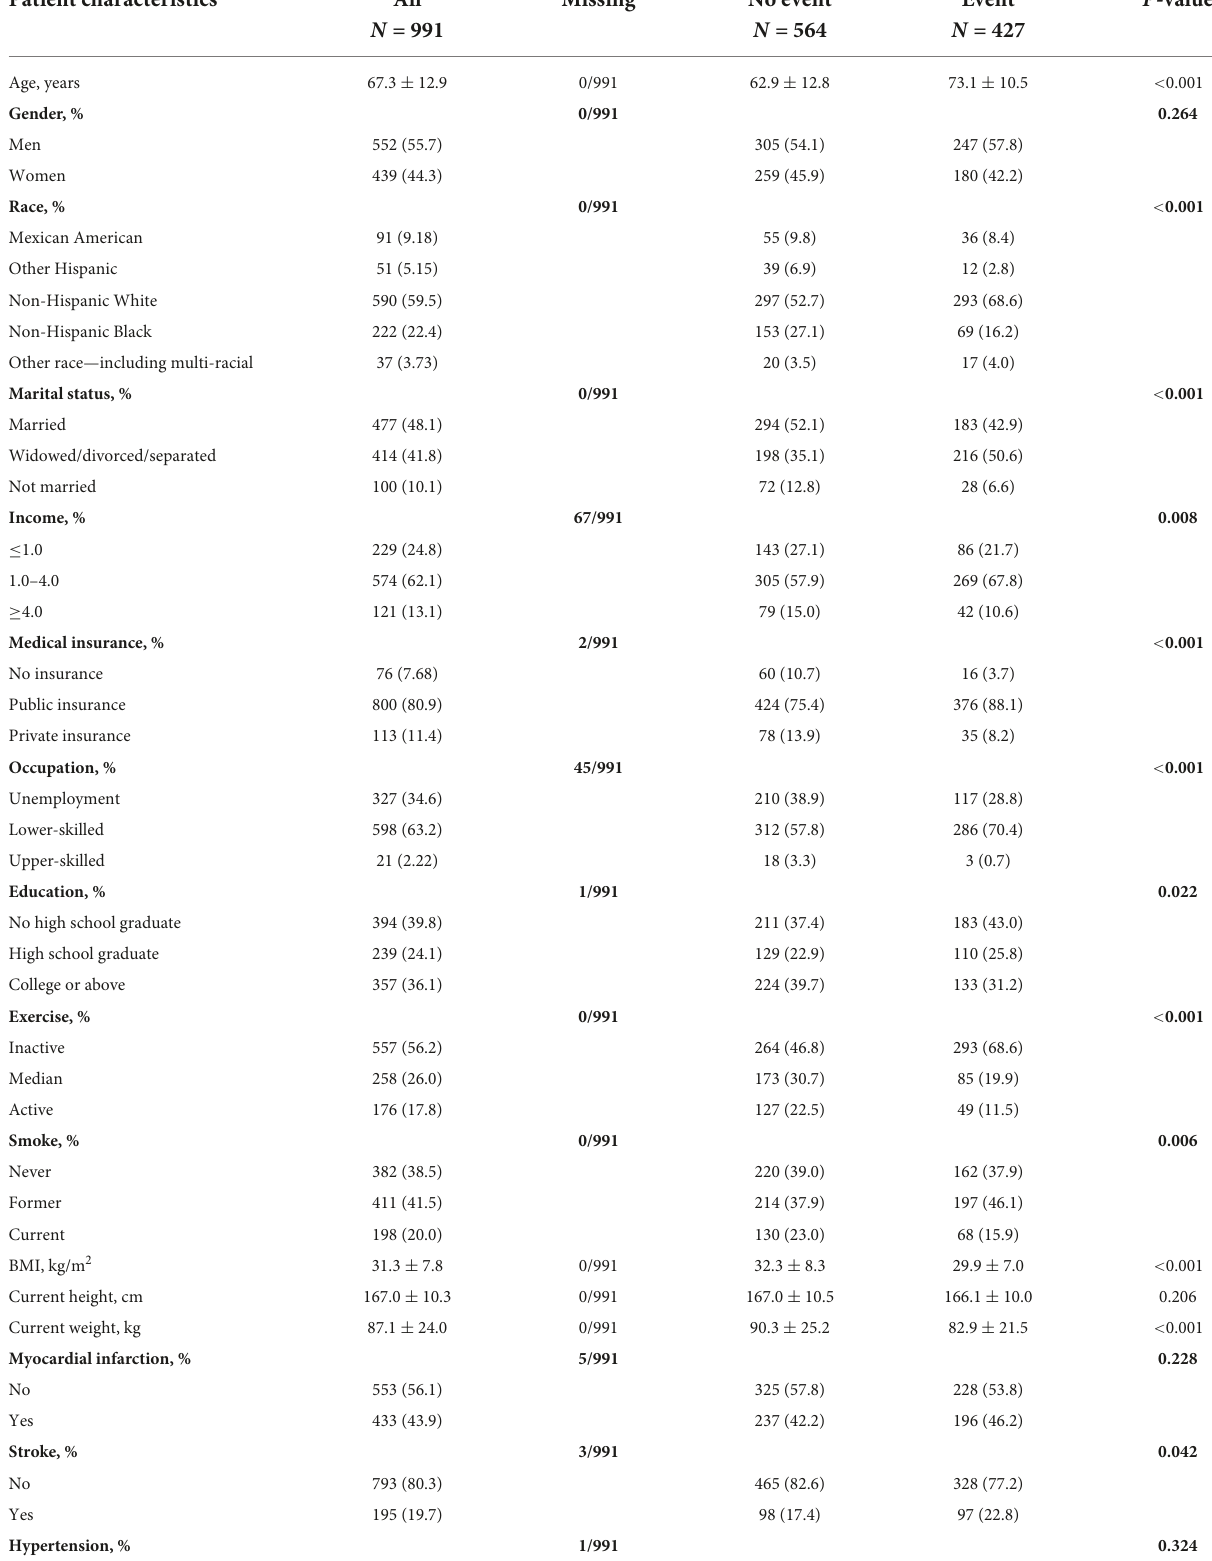
TABLE 1 Baseline characteristics of the